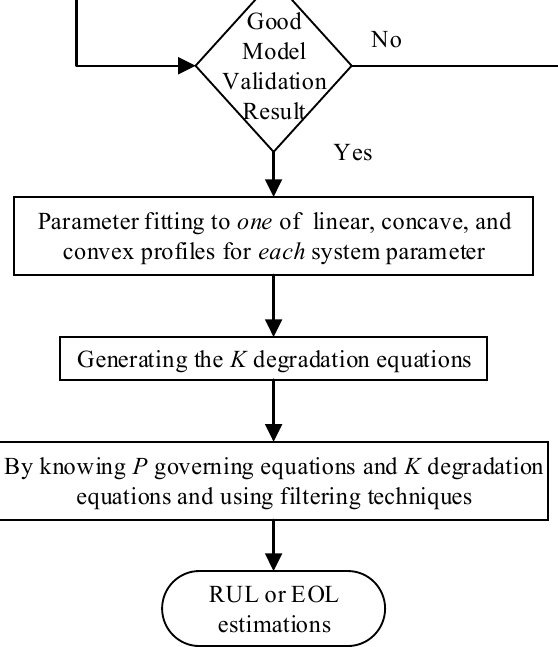
Figure 5. Flowchart of proposed approach